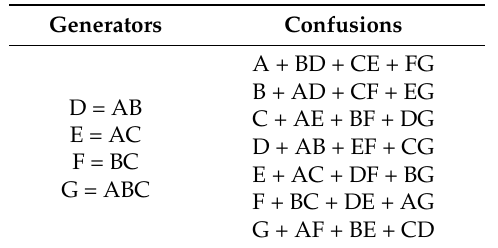
Table 5. Generators and Confusions in the (2 7 − 4 seven